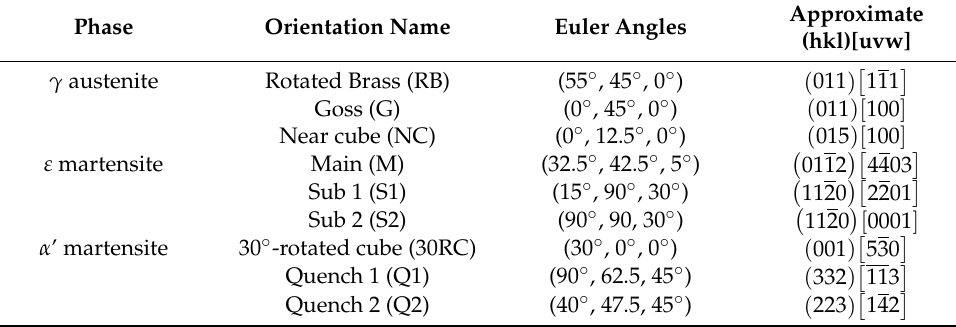
Figure 5. φ 2 sections of the ODF of ( a ) ε martensite and ( b ) α ’ martensite at ε t = 0.42. The increment of φ 2 was 5°. Table 1. Texture components observed at ε t = 0.42.